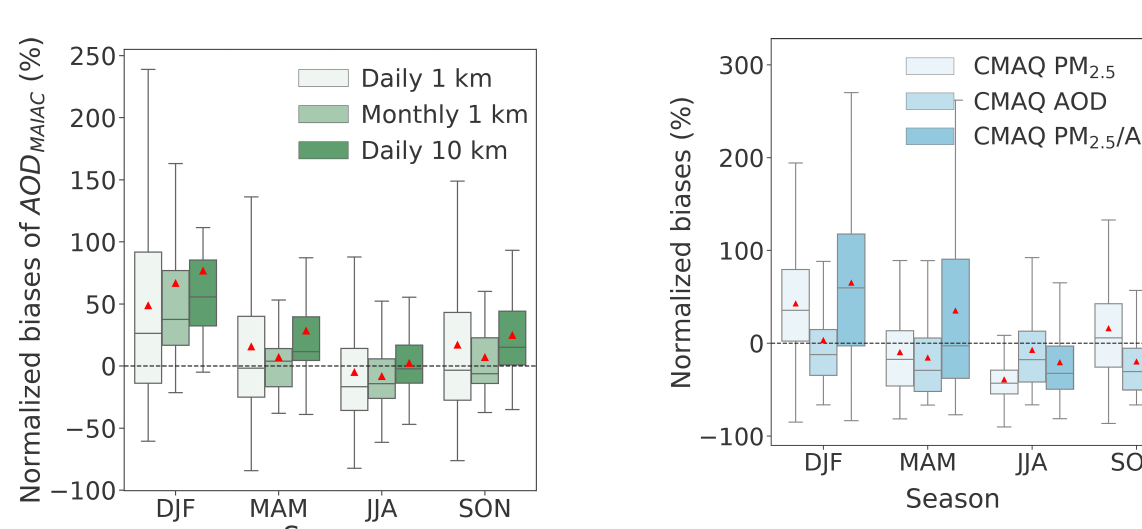
Figure 4. As in Fig. 3 but for daily PM 2 . 5_CMAQ , AOD CMAQ , and PM 2 . 5_CMAQ / AOD CMAQ in each season of 2011 evaluated at 11 co-located AQS–AERONET sites over the northeastern